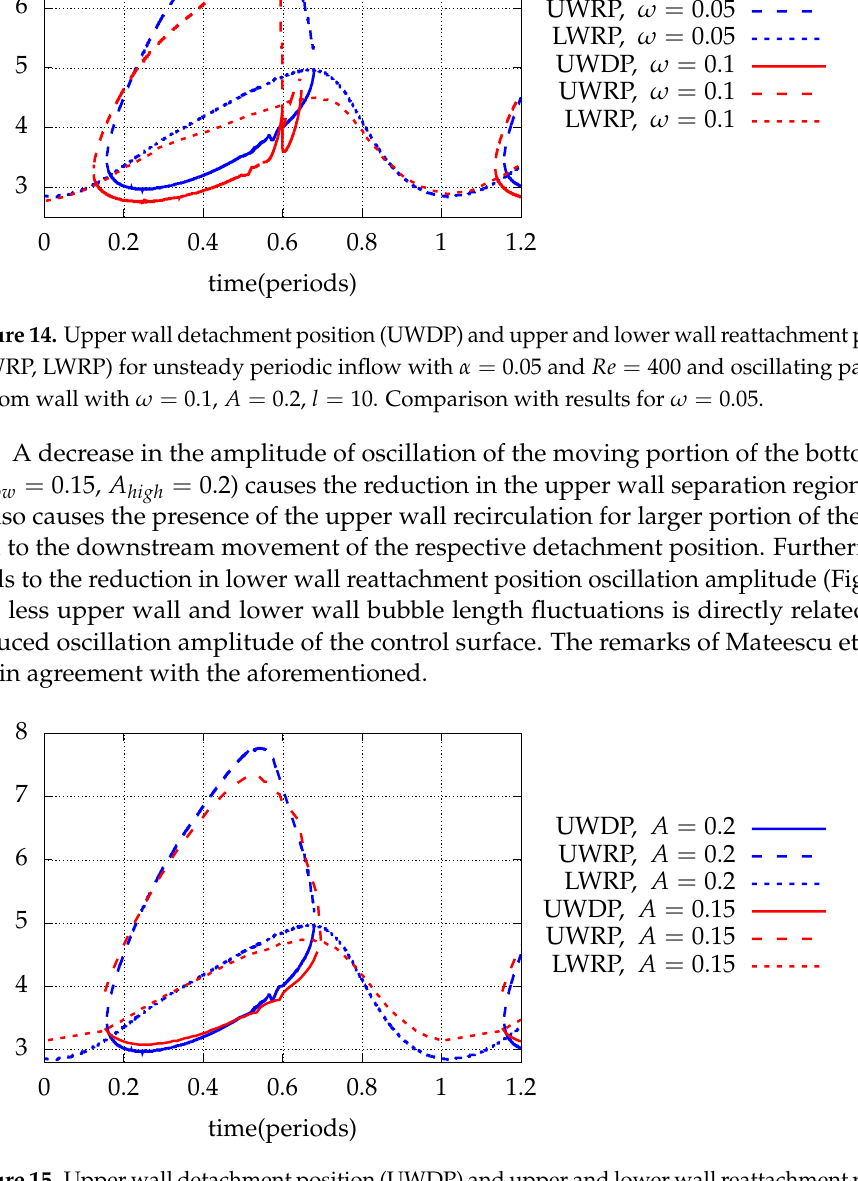
Figure 15. Upper wall detachment position (UWDP) and upper and lower wall reattachment positions (UWRP, LWRP) for unsteady periodic inflow with α = 0.05 and Re = 400 and oscillating part of the bottom wall with ω = 0.05, A = 0.15, l = 10. Comparison with results for A = 0.2. Finally, for the increase in the oscillating surface length ( l high = 12.5, l low = 10.0), the fluctuation of the bottom wall recirculation length and top wall detachment position decrease, while the presence of the upper wall recirculation extends in time, as suggested by Figure 16. This trend is attributed to the fact, that the lower wall stagnation point is more distant to the middle point of the control surface length, which exhibits maximum amplitude. Therefore, its vertical oscillation amplitude reduces and consequently its longitudinal oscillation amplitude also